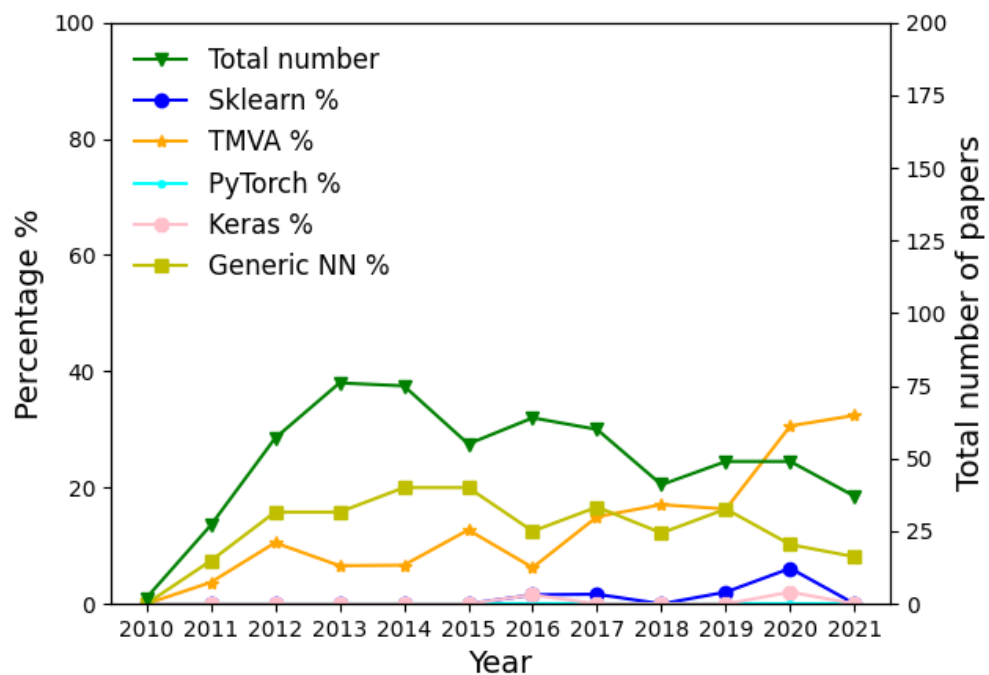
Figure 1. Usage of ML at LHCb across the years. We show the number of papers published every year (denoted as “Total number” and corresponding to the right axis), as well as the fraction of them reporting the use of TMVA, Sklearn, Keras, PyTorch and Generic NNs (in the left axis). The latter category corresponds to papers mentioning the use of NNs but never referencing any of the aforementioned libraries.